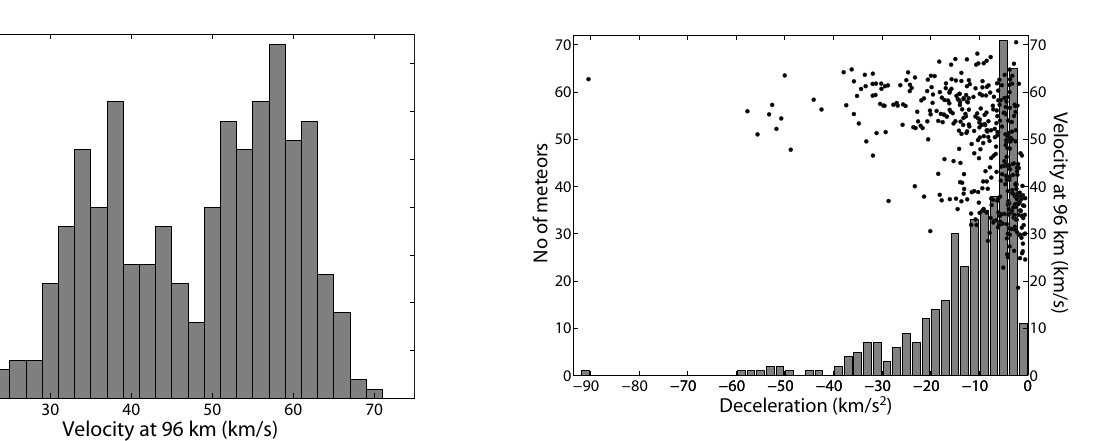
Fig. 7. Distribution of observed deceleration and a scatter plot of the velocity versus deceleration.